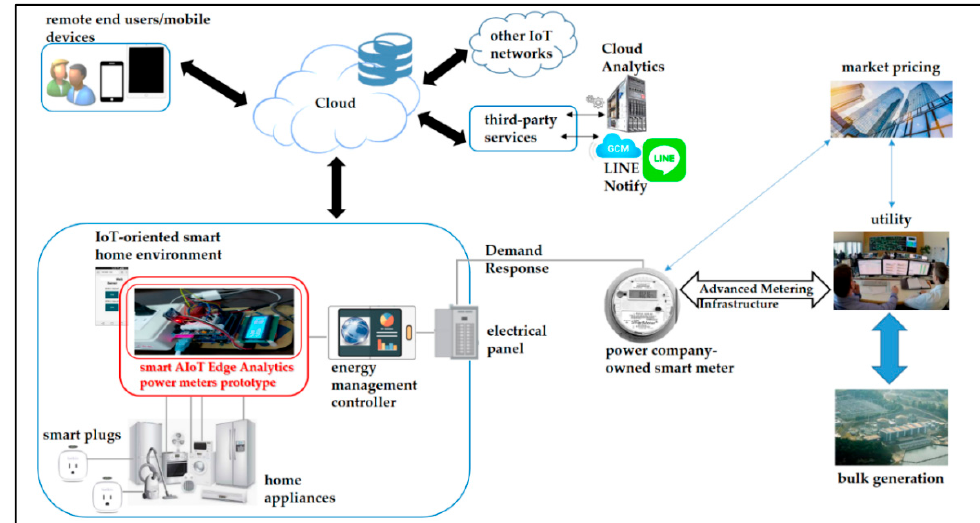
Figure 1. Typical home energy management system (EMS) model involving three main stakeholders.